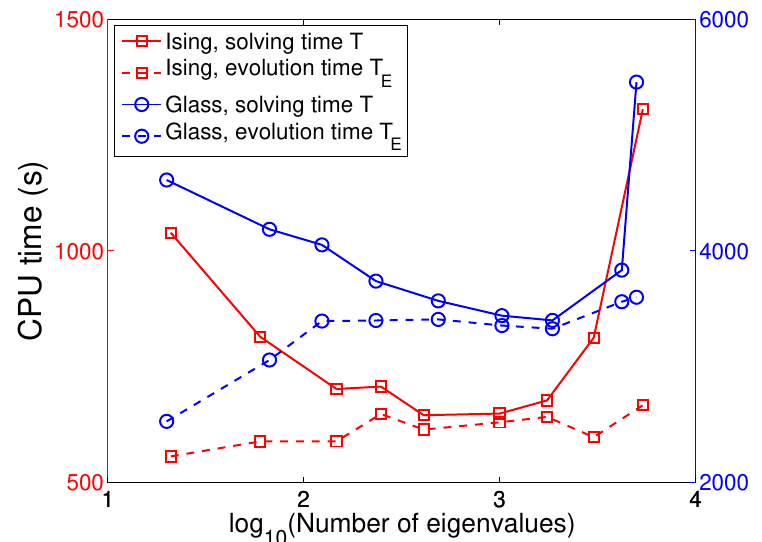
Figure 5: Computation time (CPU seconds) versus number of eigenvalues satisfying the condition η < 10 − 6 , for the Ising model (red lines with squares, left axis) and the spin glass shards (blue lines with circles, right axis), using the DACP method. For both systems, N = 15. The solid lines show the solving time T = T computation time of the exp-semicircle filtration T and of the subspace diagonalization T